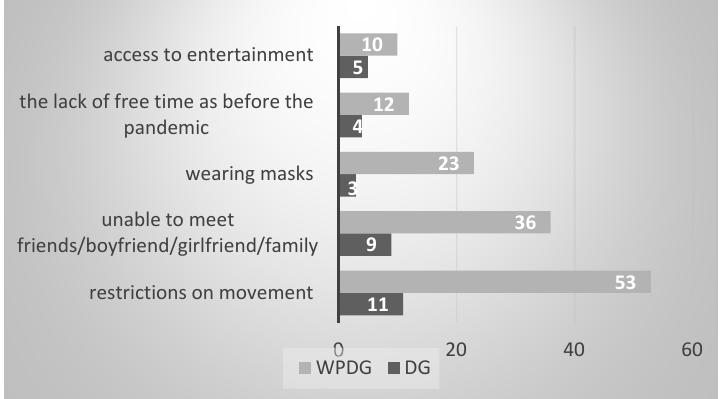
Figure 1. Examples of the most frequent limitation on individual freedom (N) described by adolescents.